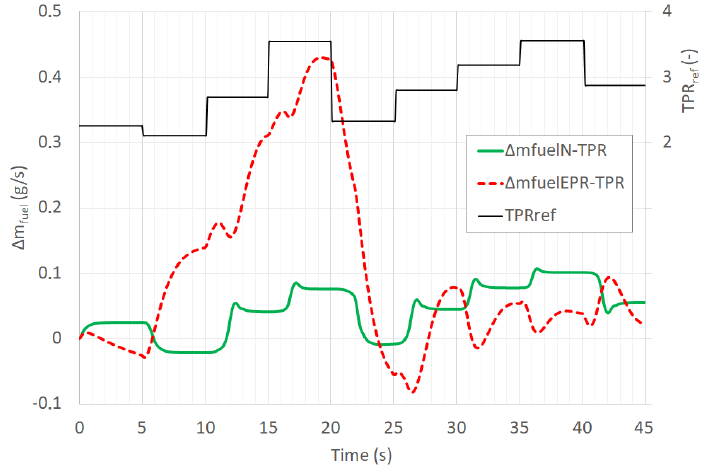
Figure 11. Difference in consumed fuel amount of rotor speed and EPR control laws with TPR being